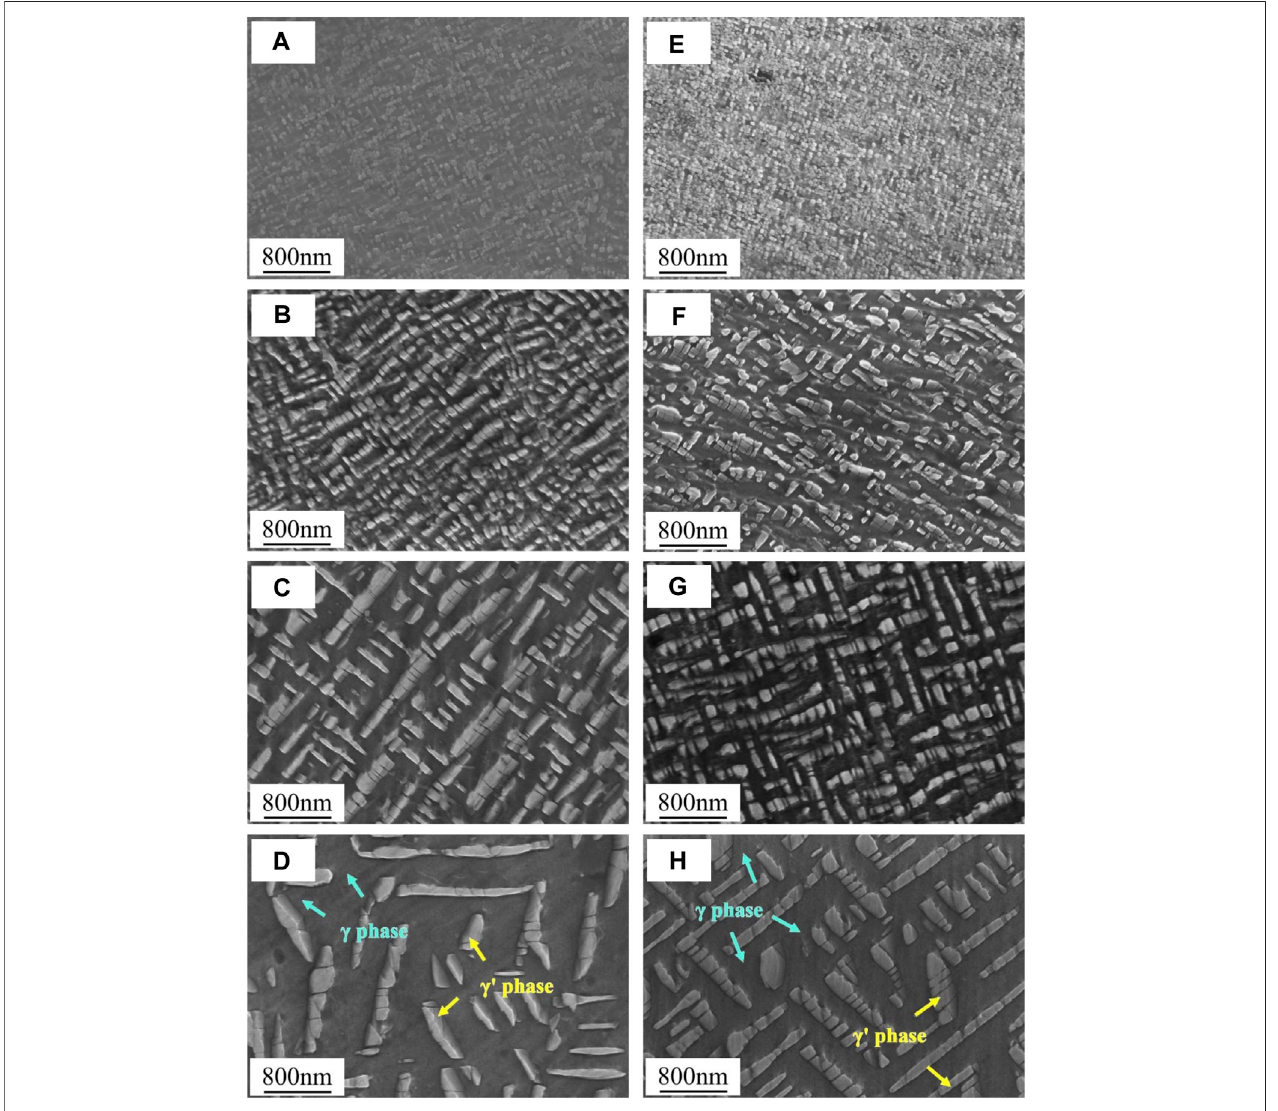
FIGURE 3 | SEM micrographs of typical microstructures in Co-Ni-Al-Ti-based superalloys: (A – D) 2Cr for 16, 64, 256, and 512 h, and (E – H) 2Mo for 16, 64, 256, and 512 h at 1073 K.